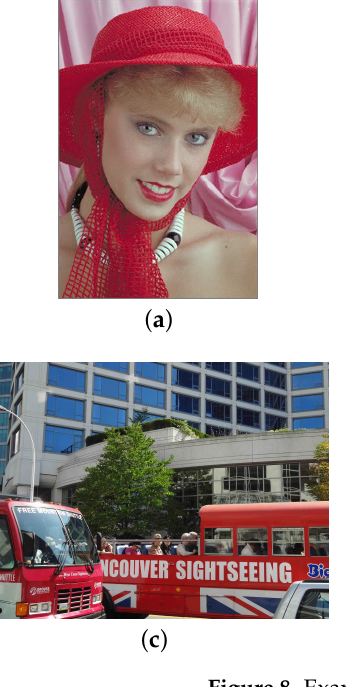
Figure 8. Examples of test images. ( a ) Kodim4 from Kodak [44]; ( b ) peppar from SIPI [45]; ( c ) ihc5 with 1/16 of original size from IHC [46]; ( d ) ihc5 with original size from